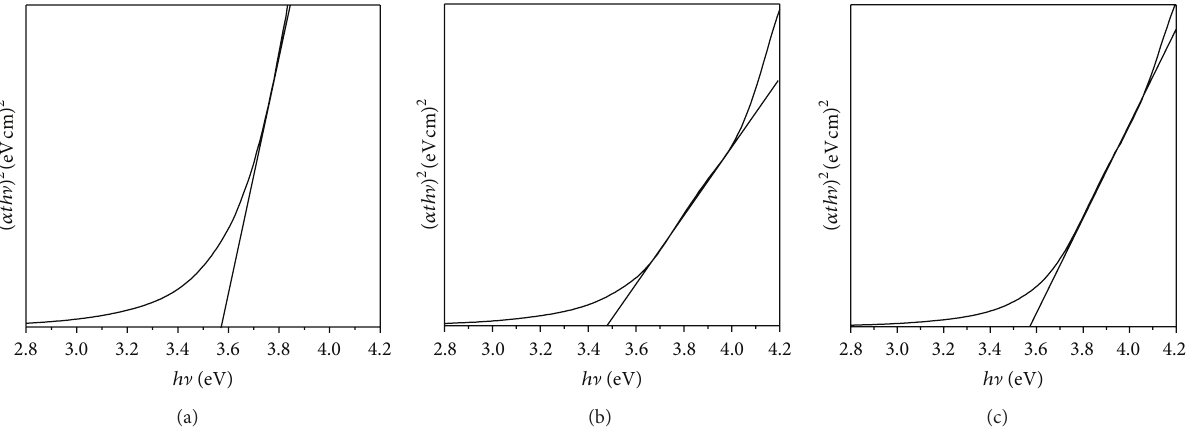
Figure 10: The relationship between (𝛼𝑡ℎ ] ) 2 and ℎ ] of synthesized TiO 2 nanoparticles: (a) 0% AC, (b) 5% AC, and (c) 10% AC.